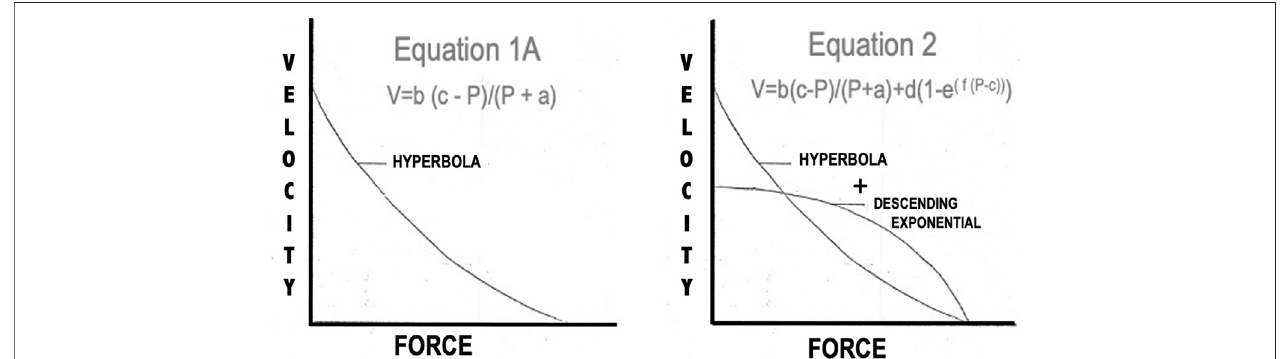
FIGURE 12 | Two models proposed to describe the shape of the Force:Velocity curves of both